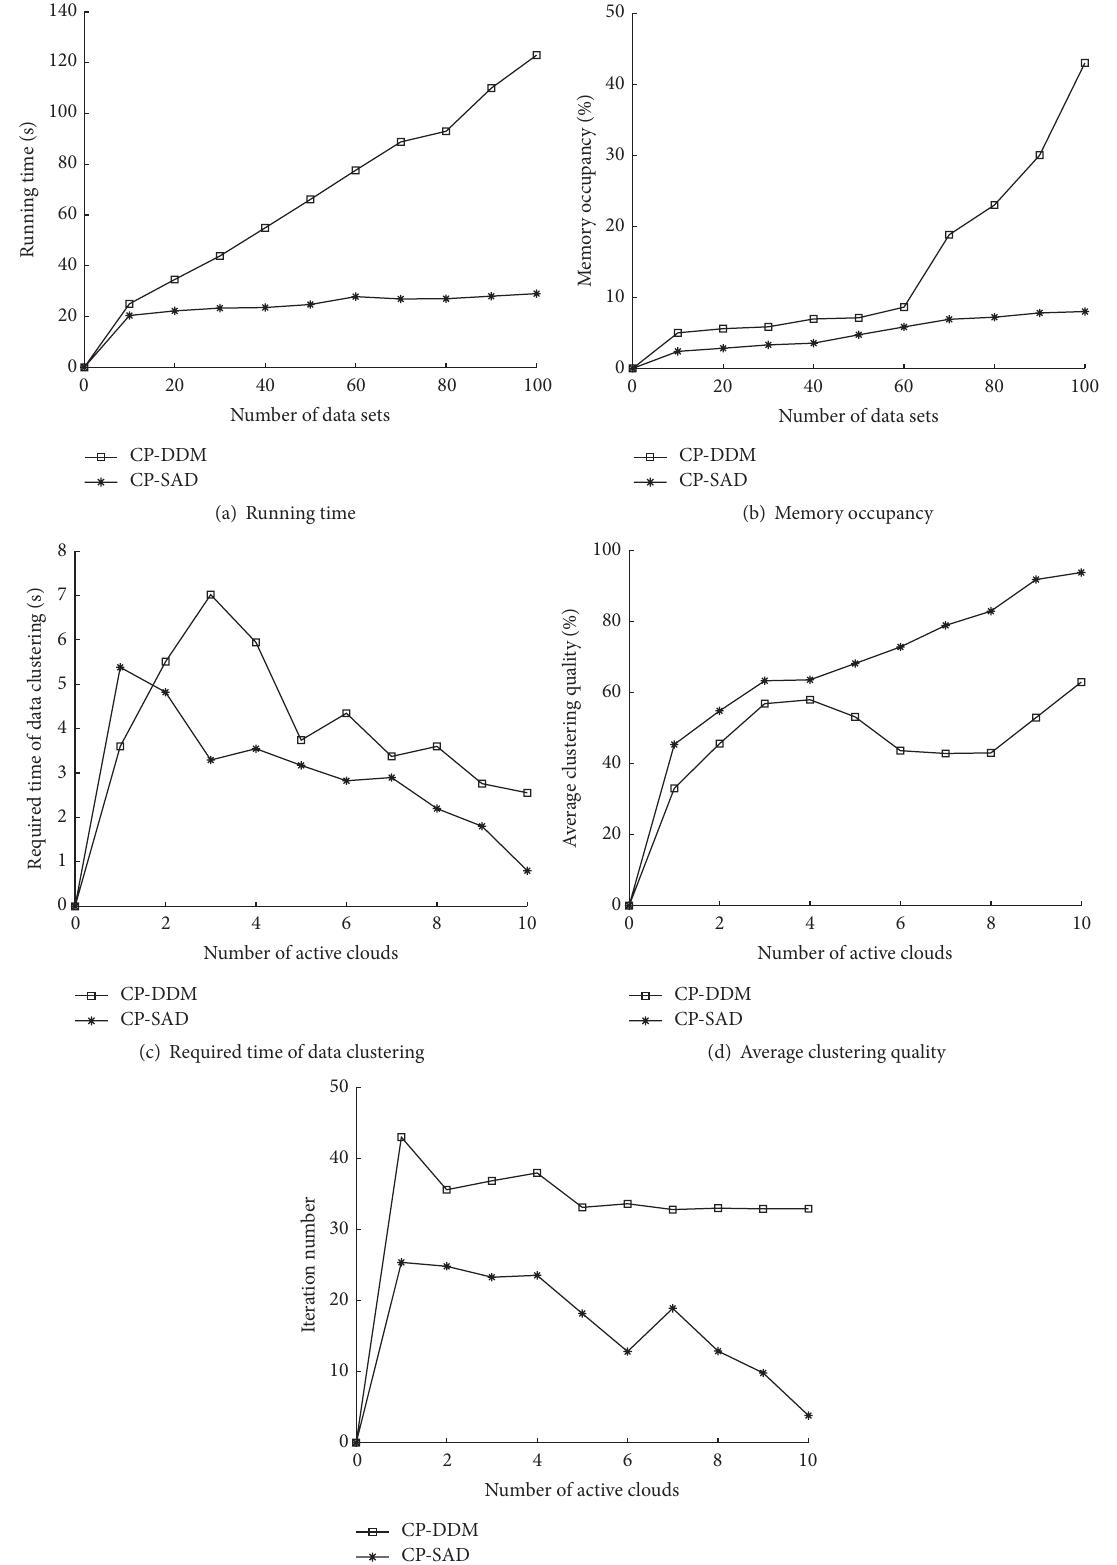
Figure 7: Performance